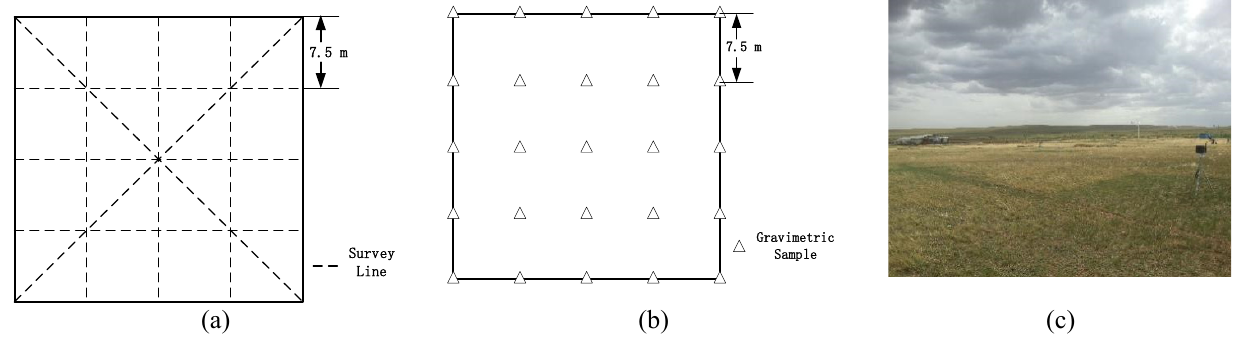
Figure 3. Experiment design of soil moisture measurement by GPR ( a ) and the gravimetric method ( b ). (the surrounding environment of the observation sites was shown in ( c